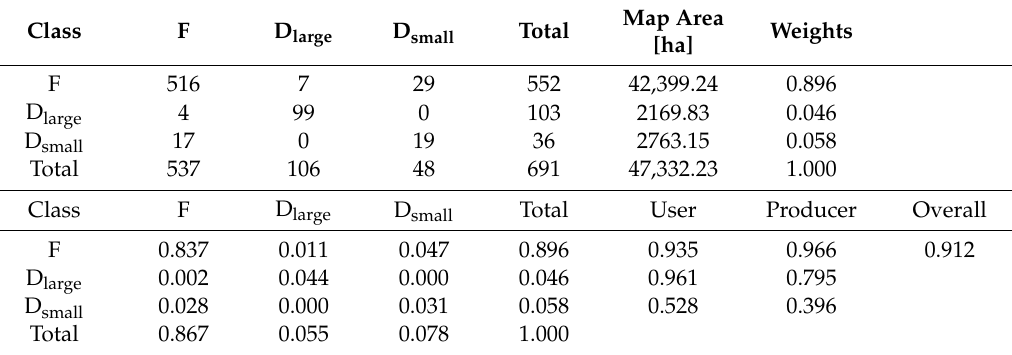
Table A13. “Optical Only” disturbance method validation Gabon (only forest